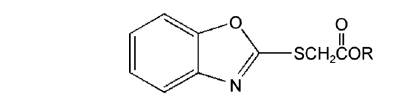
Fig. 3 The structural formula of the compound.